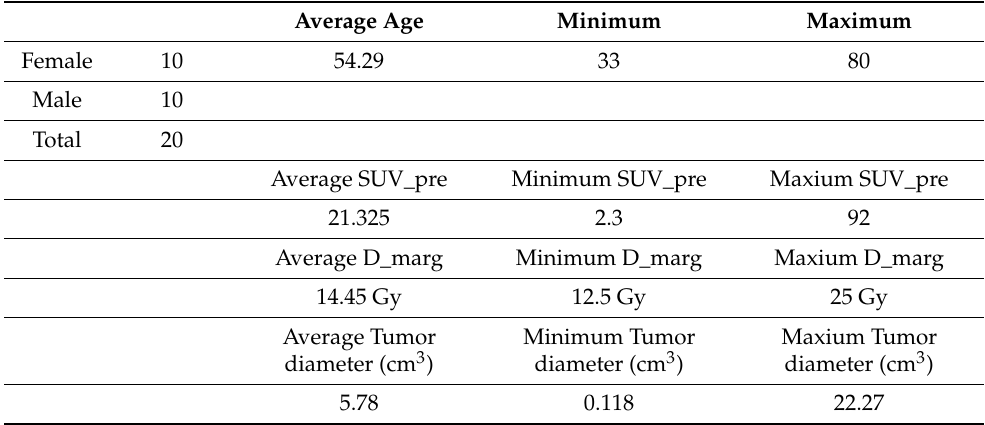
Table 2. Focus on pre- and post-Gamma Knife SUV mean values, mean age, tumor diameter distribution.